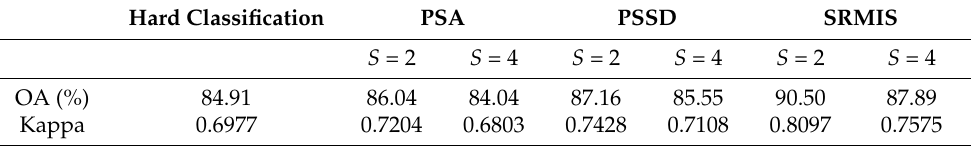
Table 2. Accuracy assessment for the classification results using a Sentinel-2 image.